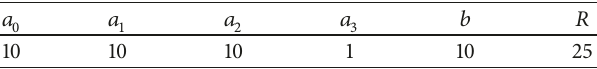
Table 4: Parameters of the augmented nonlinear tracking differen-